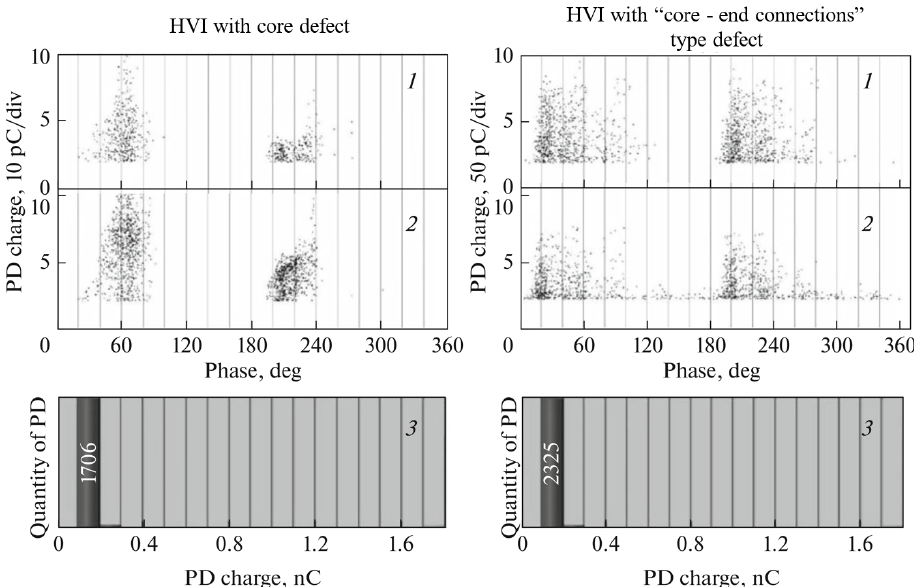
Figure 11. PD parameters for HVI samples with small defects: 1—measurement by an electromagnetic sensor, 2—measurement by an acoustic sensor, and 3—distribution of the number of PDs depending on the intensity. Table 1. PD performance parameters for the polymer HVI series.